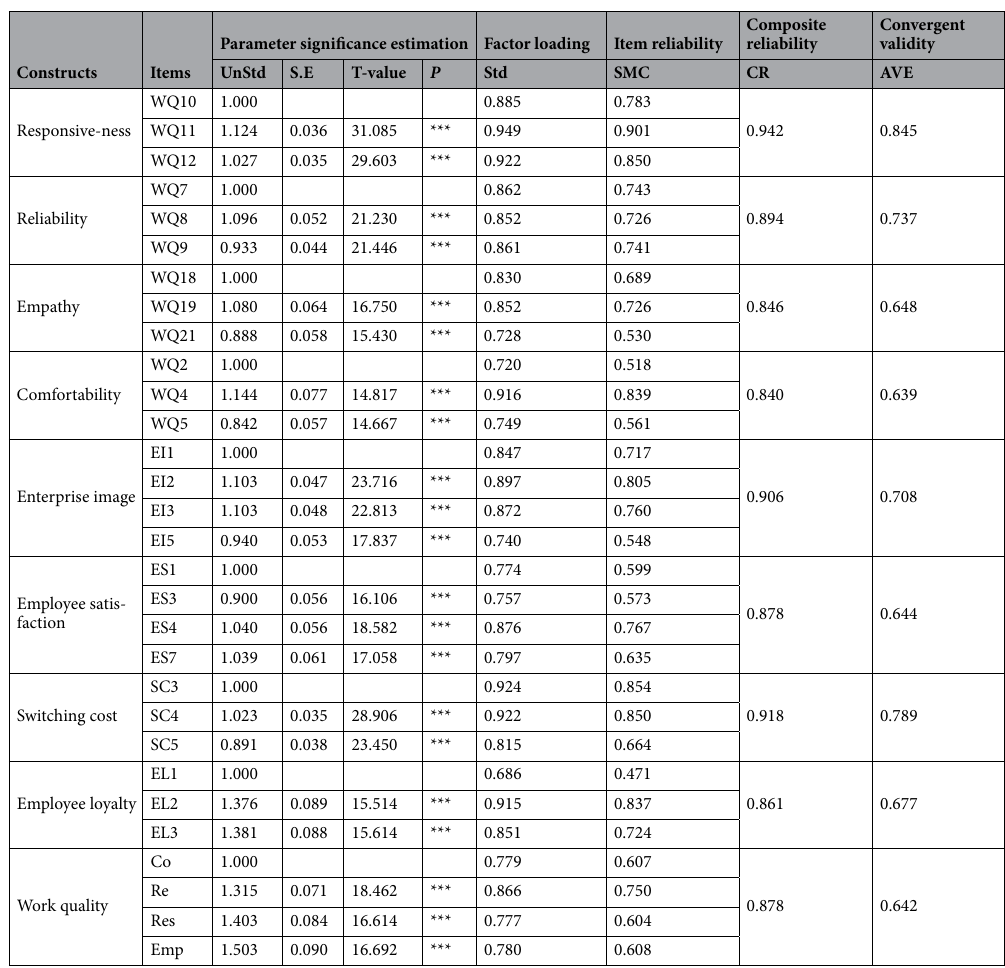
Table 3. The convergent validity of factors. ***Correlation is significant at the 0.001 level.